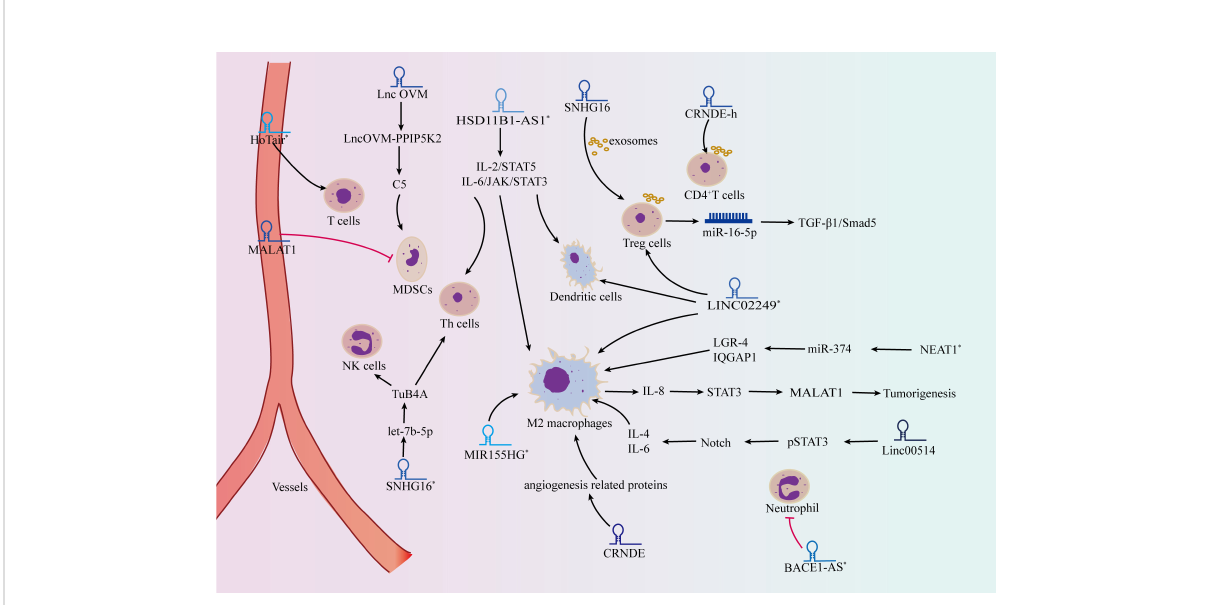
FIGURE 2 lncRNAs act as modulators in the tumor microenvironment. lncRNAs affect the occurrence and development of tumors through regulating the activity of immune cells, including CD8 + T cells, regulatory T cells (Tregs), T helper cells (Th cells), macrophages, myeloid-derived suppressor cells (MDSCs) and neutrophils. * refers to melanoma associated